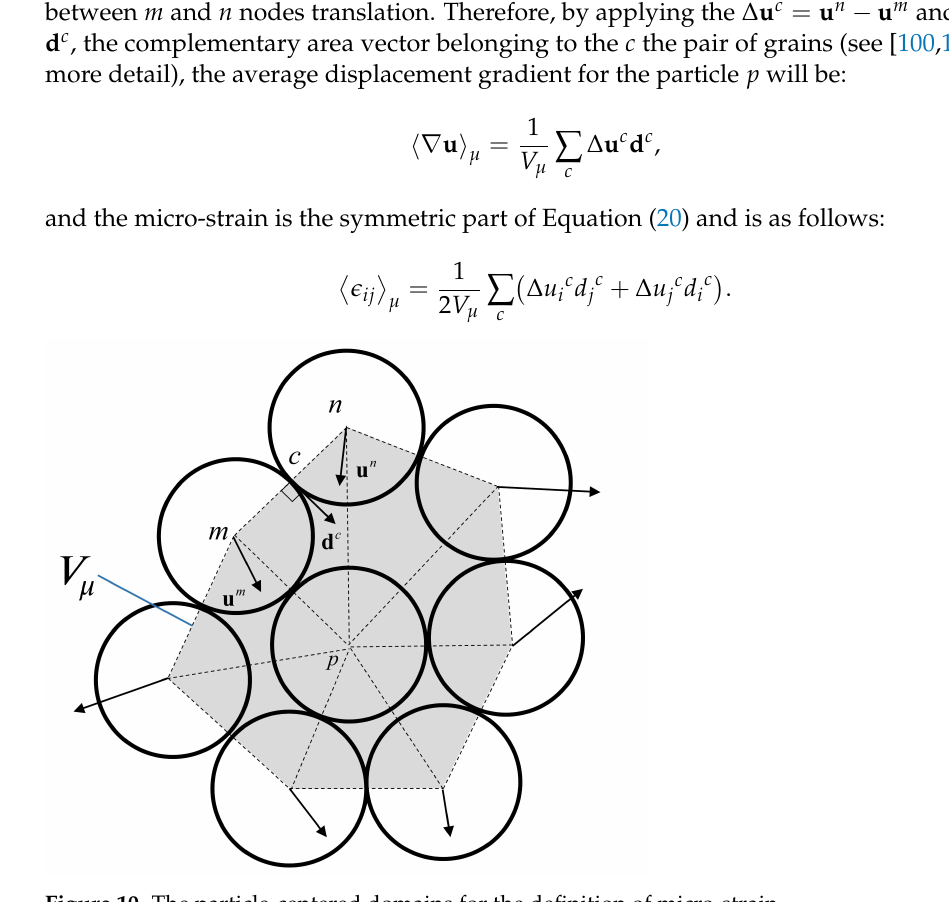
Figure 10. The particle-centered domains for the definition of